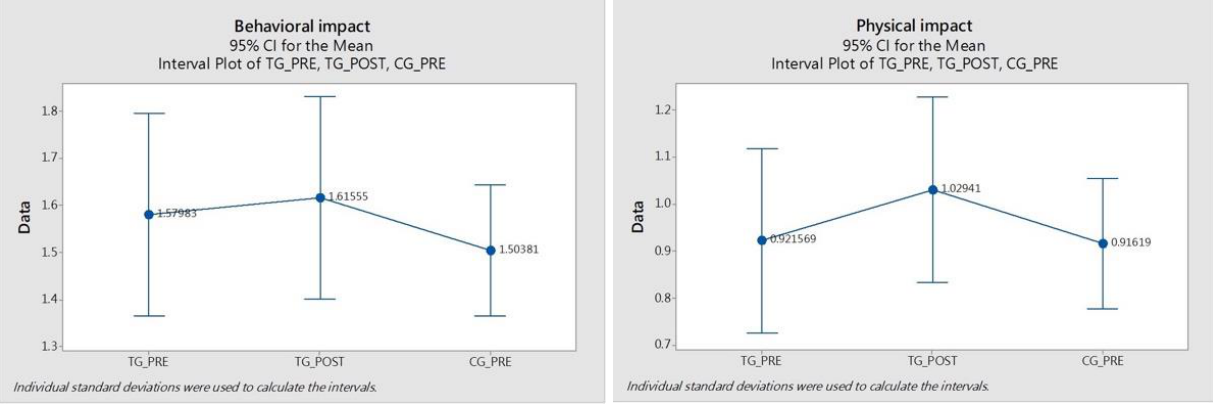
Figure 12. Interval plot for Life impact of TG_PRE, TG_POST, and CG.